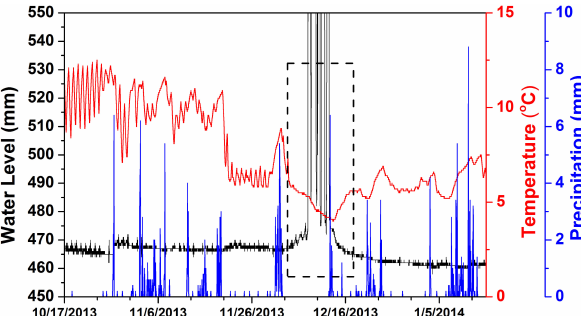
Figure 10. Effect of snowfall event and low temperature on the per- formance of the pressure transducer at the Santiam site on Oregon Highway 22. The black line is the water level inside the flow con- tainer, the red line is the water temperature, and the blue line is the precipitation. The large peaks were topped off to show other details in the black curve. The dashed line box shows the period where the sensor is affected by the snow